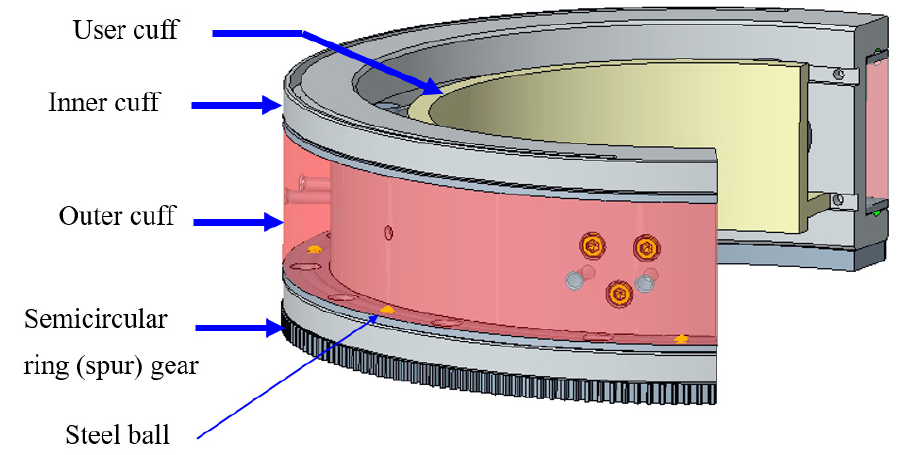
Figure 7. Upper arm sensorized cuff assembly.